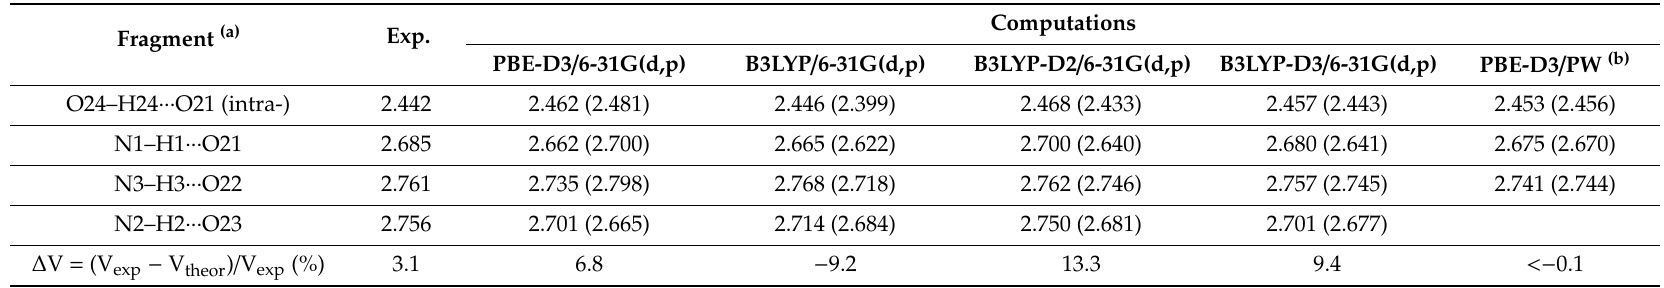
Table 1. Distances between the heavy atoms involved in the formation of conventional hydrogen bonds in [CRB + MLE] (1:1). Experiment (Exp.) vs. theoretical values. Computations at di ff erent levels of approximation with fixed unit cell parameters (AtomOnly) and full unit cell relaxation (FullOpt). The FullOpt values are given in parentheses. The units are Å. The relative change in the volume of the crystallographic cell ∆ V is given in the last line.